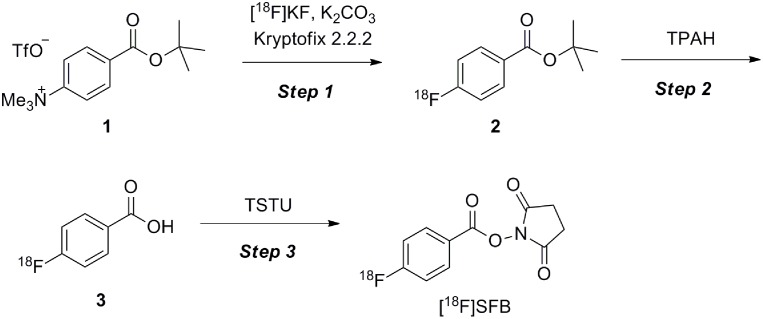
Synthetic method for [18F]SFB.